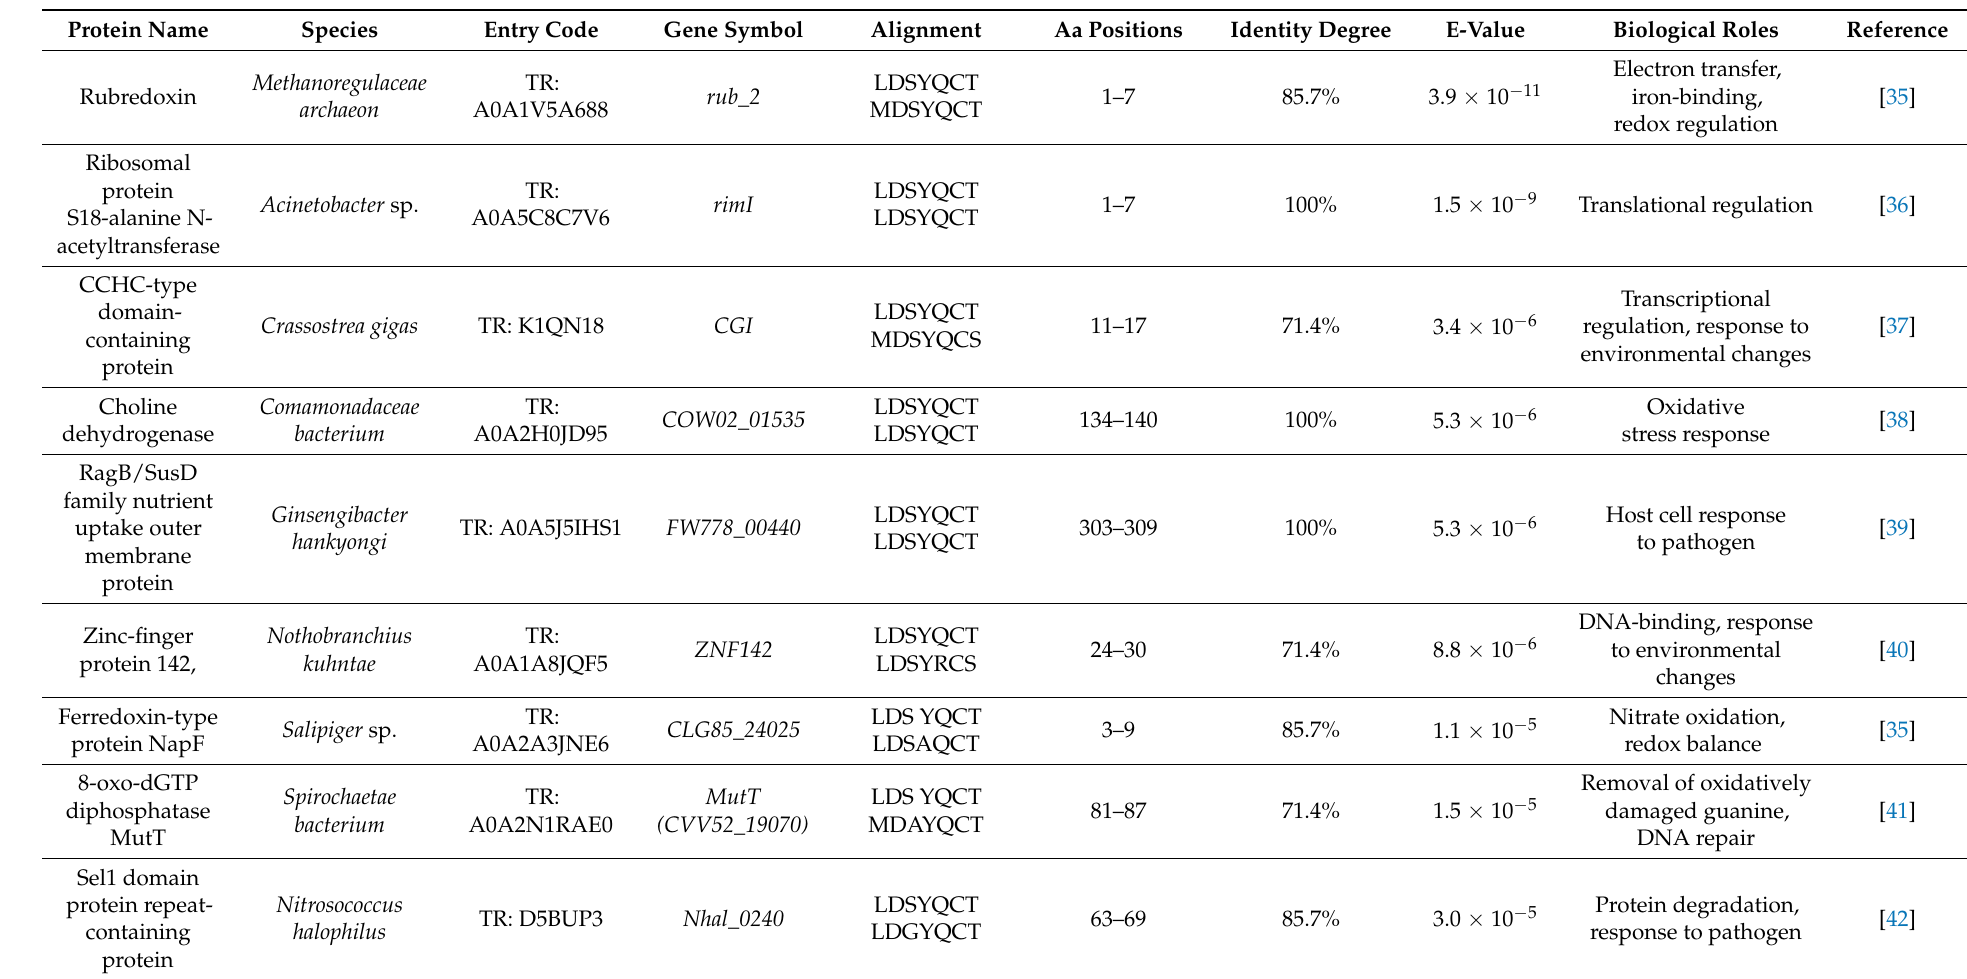
Table 1. Representative proteins retrieved from the UniProtKB database as containing AFP 14–20 -like motifs (at E-value <